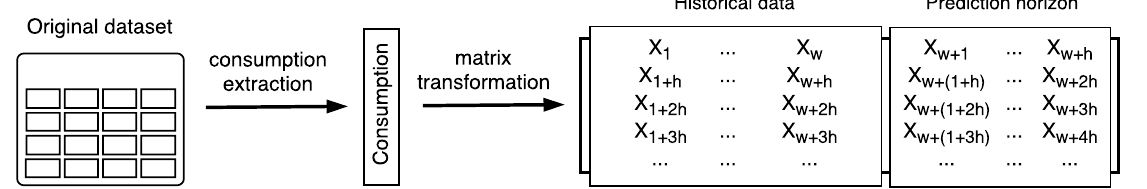
Figure 2. Dataset pre-processing. w determines the amount of historical data used, while h represents the prediction